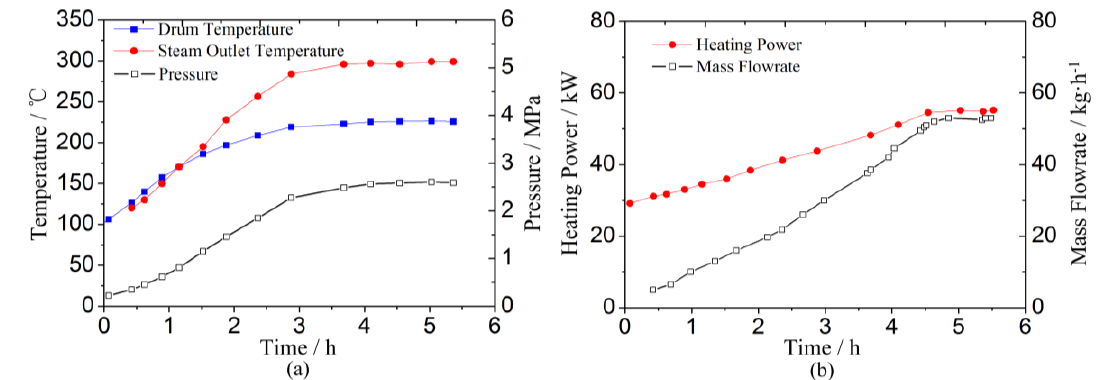
Figure 5. Start-up curves under operating pressure p = 2.6 MPa.